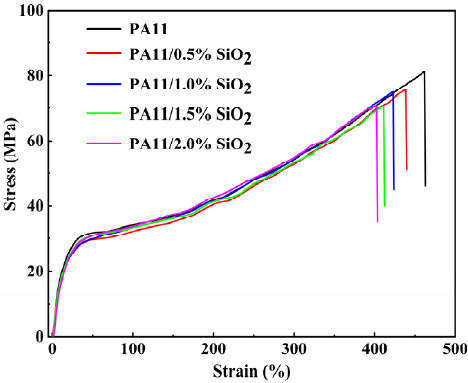
Figure 8. The stress–strain curves of PA11 and PA11/SiO 2 composites. Table 2. Mechanical properties of PA11/SiO 2 composites.